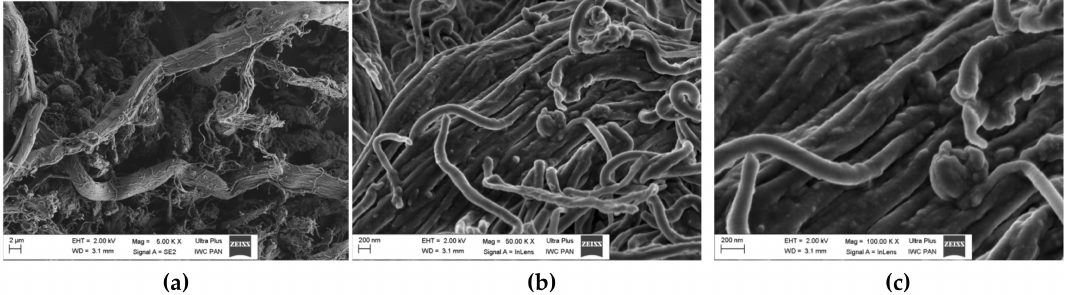
Figure 2. SEM images of bu ffi ng dust collagen (BDC): ( a ) 5000 × magnification, ( b ) 50,000 × magnification, and ( c ) 100,000 ×